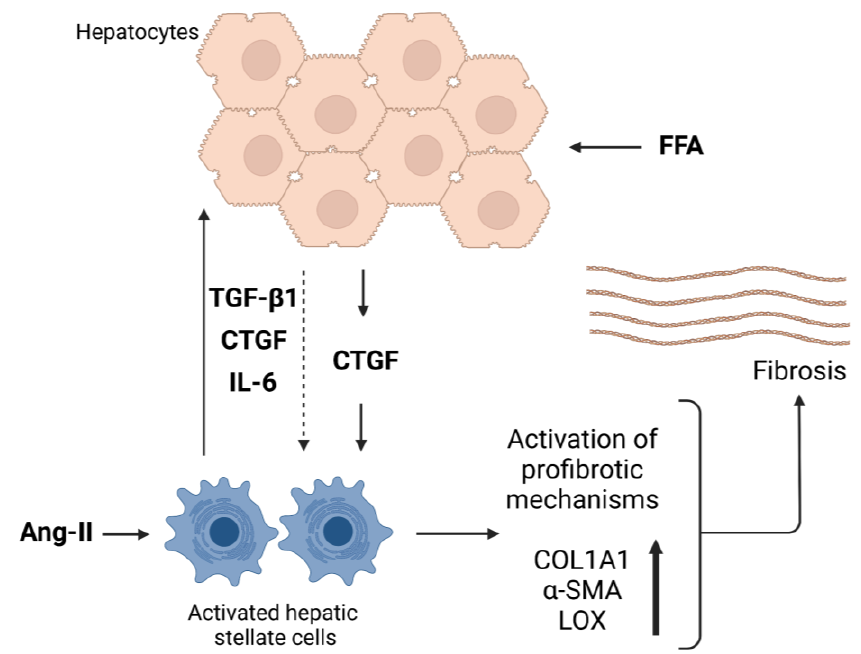
Figure 7. Proposed schematic overview of CTGF’s function in liver fibrosis in the spheroid model. Under stress conditions, CTGF can be produced by both hepatocytes and activated hepatic stellate cells and can, in addition, itself induce production and release of TGF- β 1, IL-6 and CTGF from the co-culture spheroids. Free fatty acids (FFA) create a profibrotic environment, in which co-culture spheroids produce CTGF. Consequently, profibrotic mediators are released from hepatic stellate cells. The profibrotic mechanisms are activated and the production of COL1A1, α -SMA and LOX increases. ECM then accumulates in the spheroids as a final consequence of FFA treatment. Angiotensin II binds to the AT1 receptor on hepatic stellate cells and, through its downstream signaling, induces the production of CTGF and, consequently, other mediators as well. α -SMA— α smooth